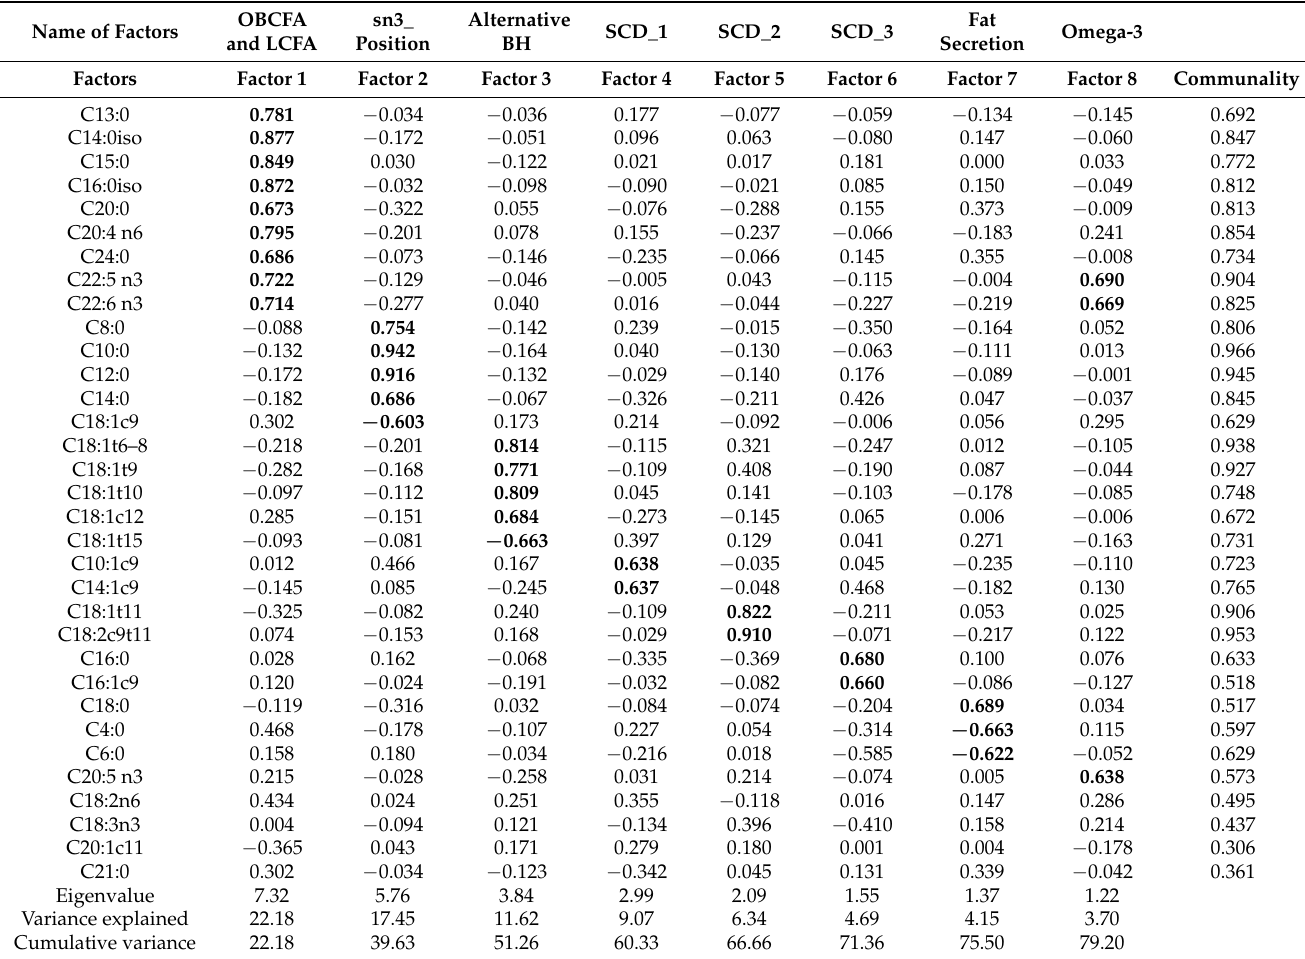
Table 2. Rotated factor (F) pattern and proposed factor